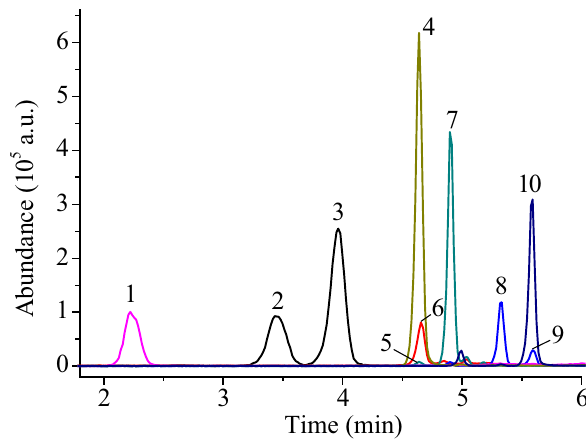
Fig. 3 Derivative efficiencies of different reaction times for the rep- resentative steroids in human serum at reaction temperature of 40 °C